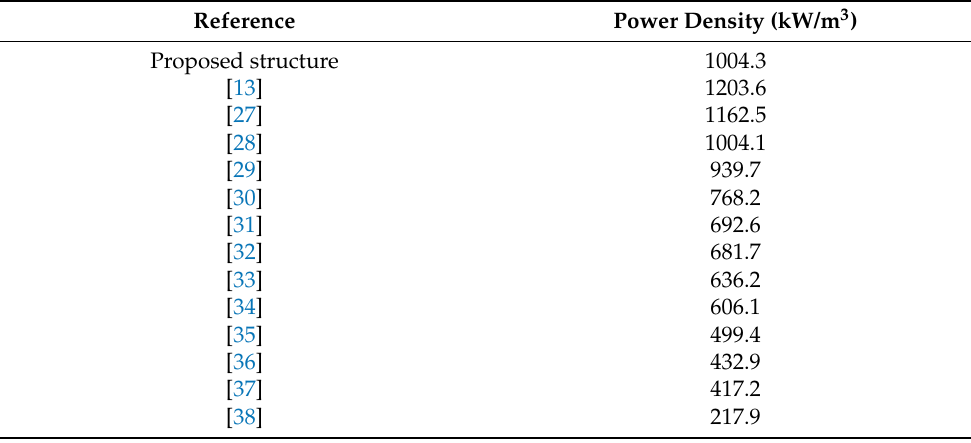
Table 3. A comparison of power density with other radial-flux PM